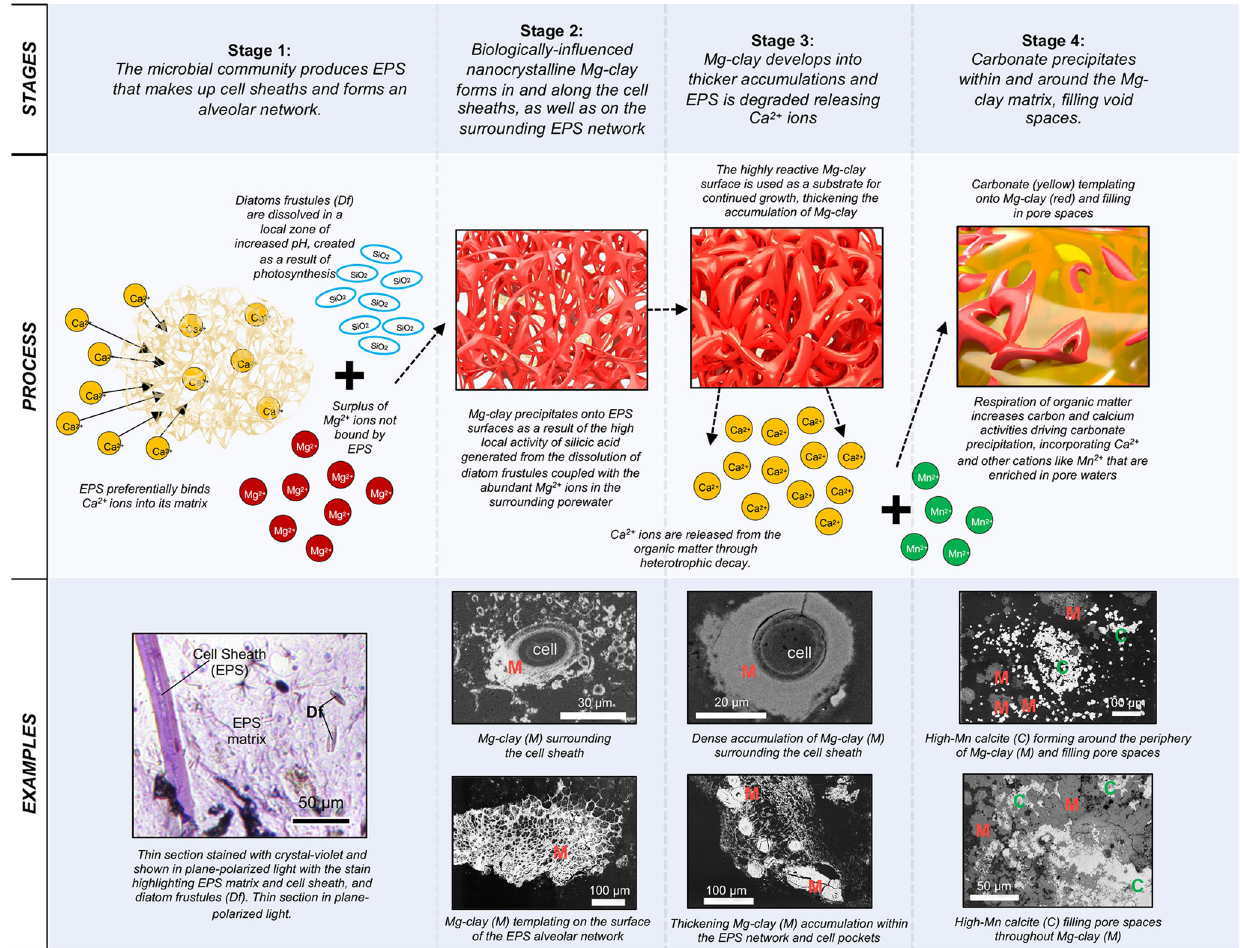
Fig. 8 Summary diagram. Four-stage model showing how Mg-clay pays a critical role in the mineralization pathway for carbonate in the Puquios of the Salar de